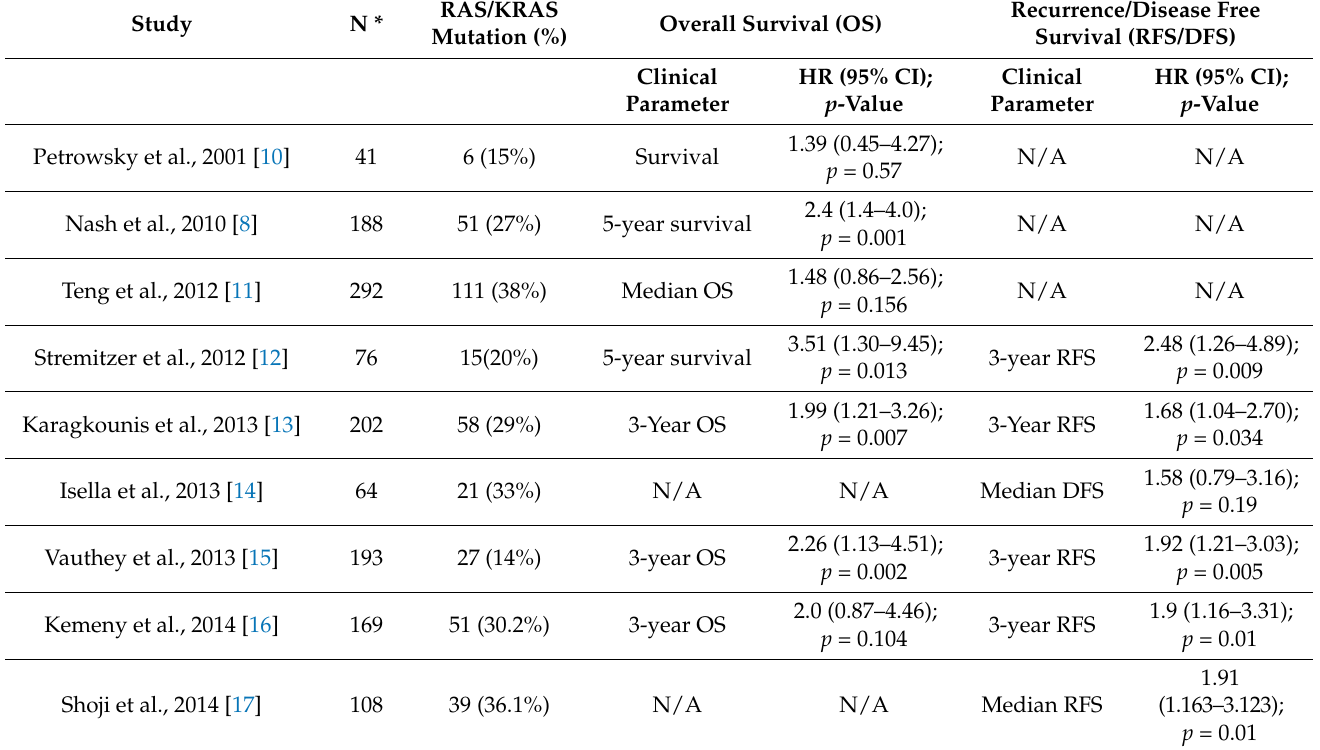
Table 1. Summary of studies reporting survival outcomes of treatment of colorectal liver metastases according to RAS/KRAS